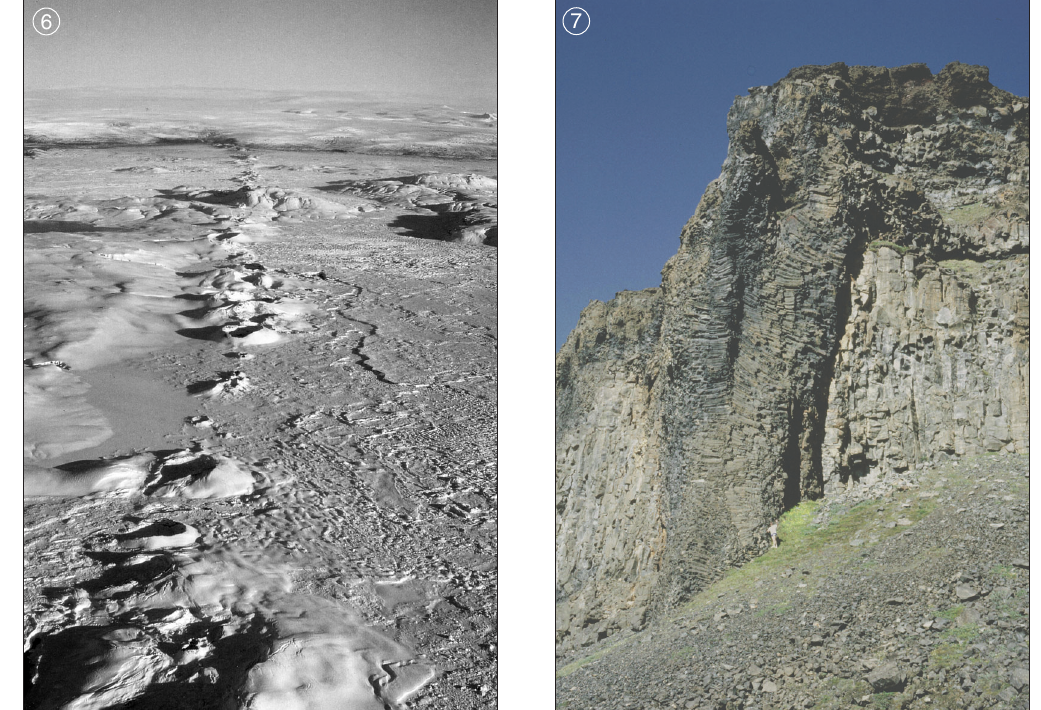
Fig. 6. Part of a volcanic fissure with crater cones in the Grimsvotn Volcanic System of the East Volcanic Zone (fig. 5). View northeast, this crater row, which has a total length of 27 km (Thordarson and Self, 1993), was formed during the Laki 1783 eruption, the largest historical eruption in Iceland. Fig. 7. On solidification, subvertical magma-driven fractures that reach the surface become feeder dykes, like this 6000-8000-year-old feeder dyke in the canyon of the river Jokulsa a Fjollum, at the eastern margin of Frem- rinamur Volcanic System of the active rift zone in North Iceland (fig. 5). The dyke is around 6 m thick where the person is standing, but gradually increases in thickness to around 10 m where it meets the free surface at the time of eruption and connects with a crater cone ( cf. Gudmundsson,